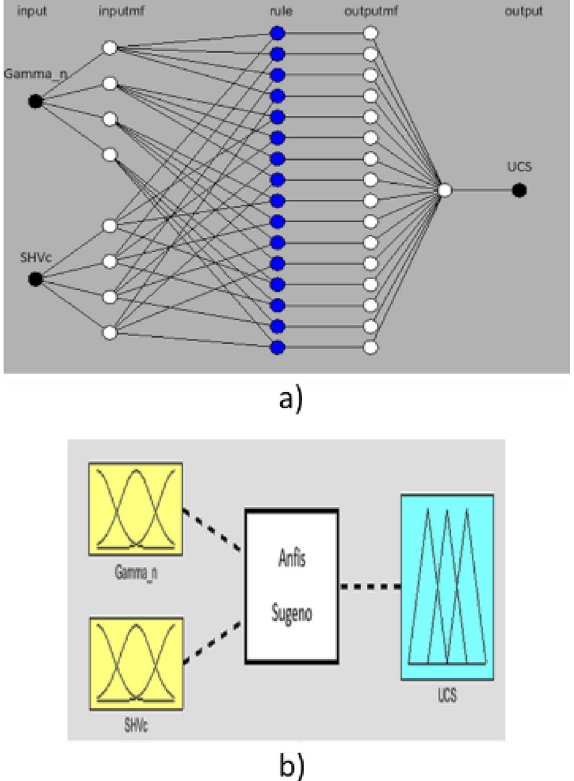
Figure 9. ( a ) The Anfis fitted model, ( b ) the Anfis path.